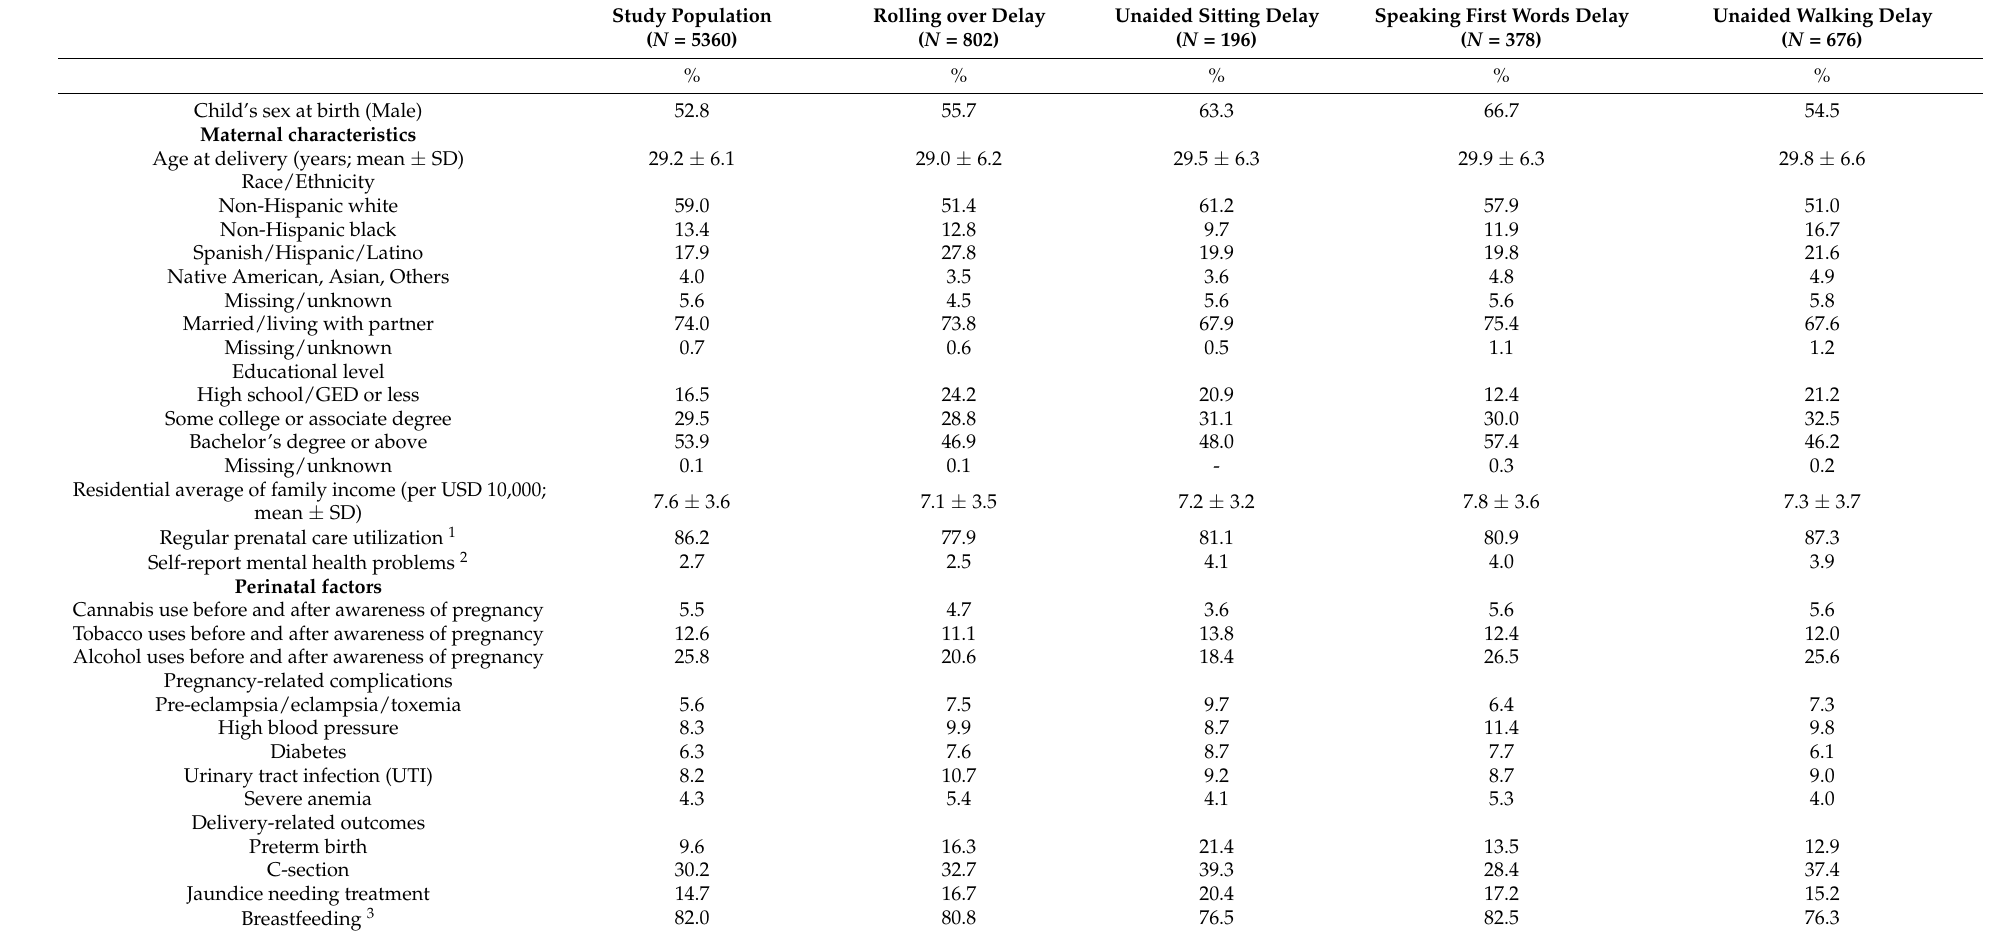
Table 1. Characteristics of the study population and children with delays in milestone